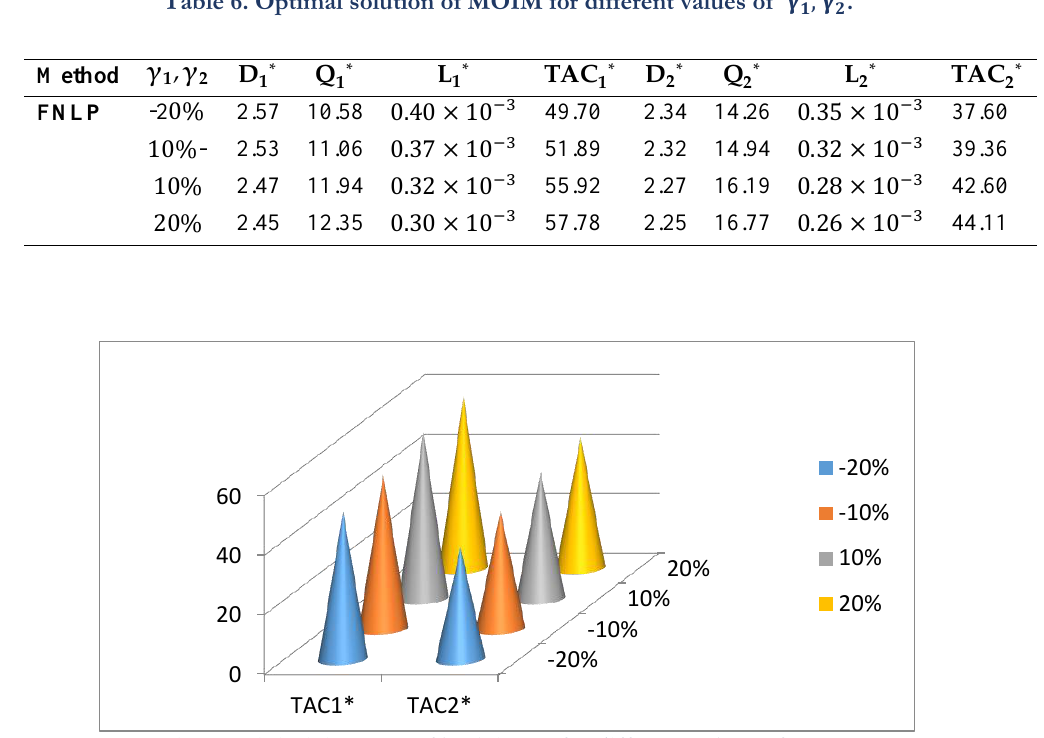
Table 6. Optimal solution of MOIM for different values of 𝛄 𝟏 , 𝛄 𝟐 .